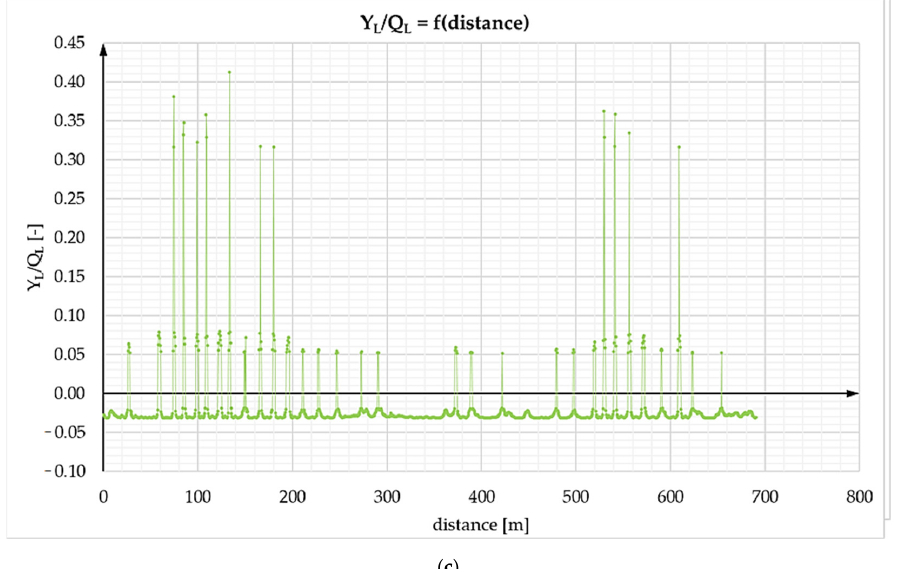
Figure 16. ( a ) Course of the Y/Q ratio for the left rail, for rail inclination 1: ∞ and travel speed 200 km/h; ( b ) course of the Y/Q ratio for the left rail, for rail inclination 1:40 and travel speed 200 km/h; and ( c ) course of the Y/Q ratio for the left rail, for rail inclination 1:20 and travel speed 200 km/h.